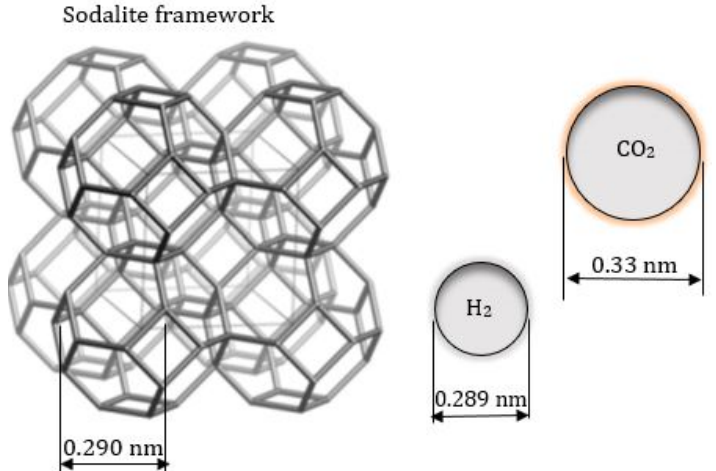
Figure 1. Relative size of SOD structure compared to the kinetic diameter of H 2 and CO 2 molecule. HSOD structure adapted from Treacy and Higgins [32] and H 2 and CO 2 diameter from Jansen et al. [33] and Xu et al. [34].